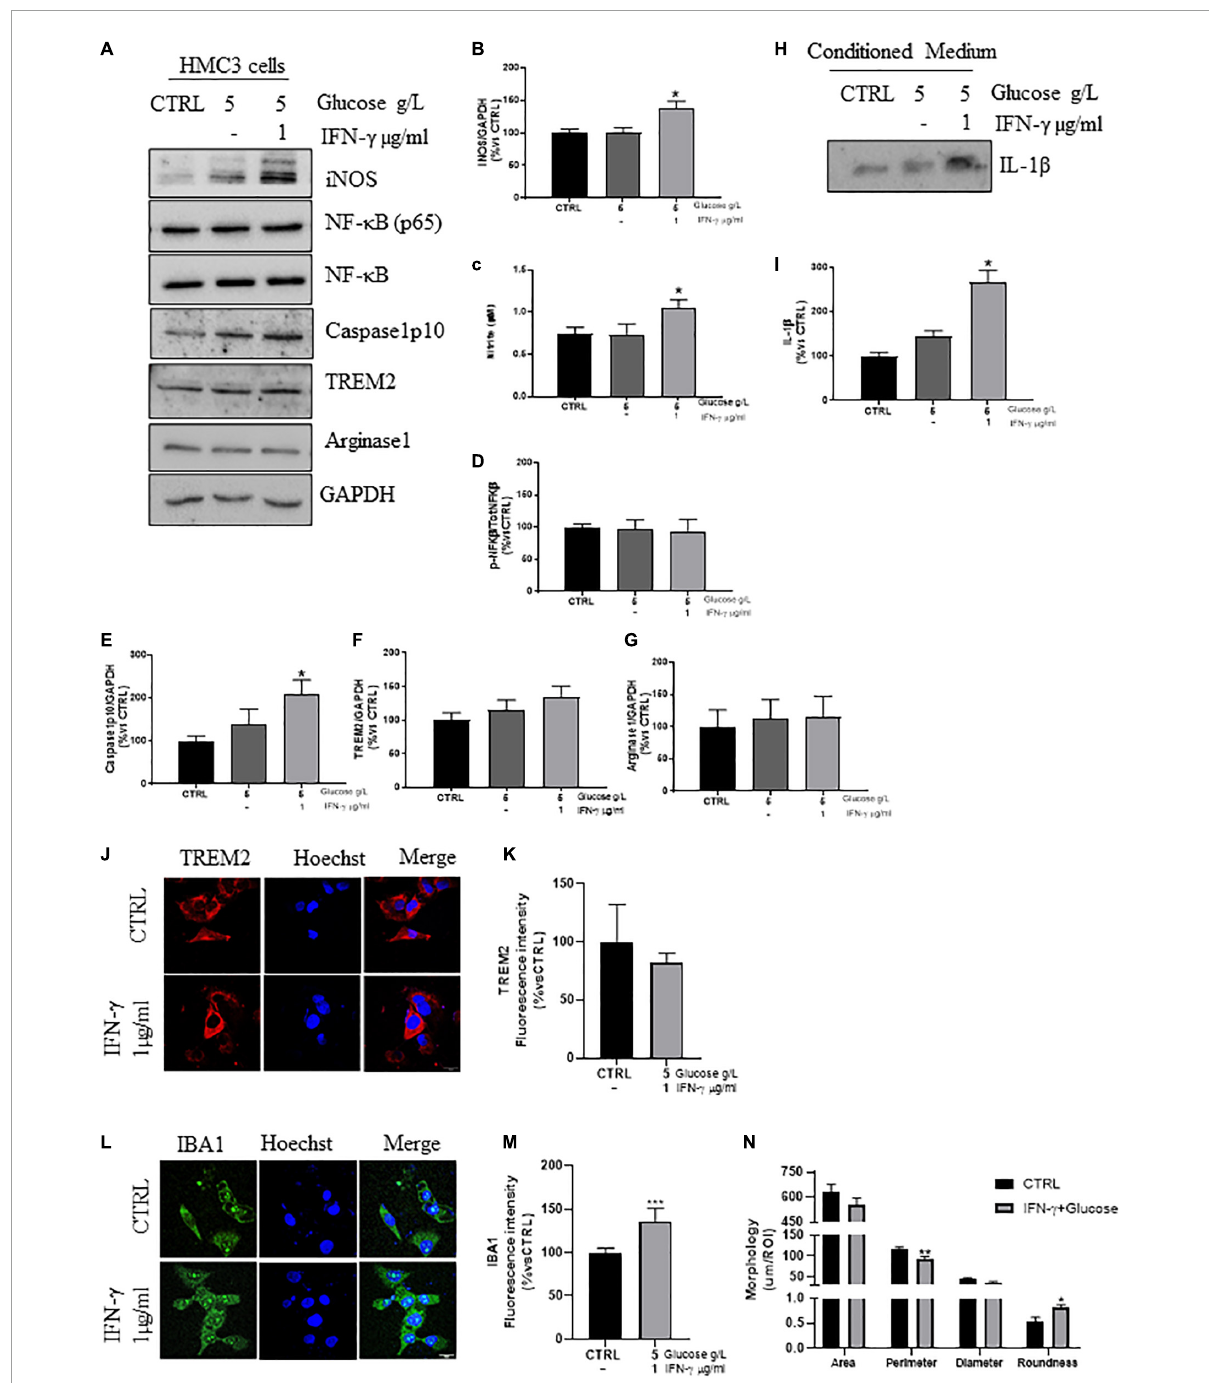
FIGURE1 Phenotypic markers expression in human microglial clone 3 cell line (HMC3) treated with IFN- γ + glucose. Western blot analysis and relative densitometry of iNOS (A,B) , Caspase1 (A,E) , NF- κ B(p65)/NF- κ B (A,D) , TREM2 (A,F) , Arginase1 (A,G) , in lysed HMC3 cells treated with glucose (final concentration 5 g/l) or IFN- γ 1 µ g/ml + glucose (final concentration 5 g/l) for 24 h in serum free medium vs. the reference protein GAPDH. IL-1 β expression (H,I) and nitrite quantification (C) in conditioned medium of HMC3 cell treated with glucose (final concentration 5 g/l) or IFN- γ 1 µ g/ml + glucose (final concentration 5 g/l) for 24 h. Results are the mean ± s.e. of independent experiments. N = 3 for Caspase1, NF- κ B(p65)/NF- κ B, IBA1, and IL-1 β . N = 5 for iNOS, TREM2, and Arginase1. Representative immunofluorescence and relative quantification of fluorescence intensity of TREM2 (J,K) , and IBA1 (L,M) and morphology analysis of IBA1 + cells (L,N) in HMC3 cells treated with IFN- γ 1 µ g/ml + glucose (final concentration 5 g/l) for 24 h. N = 3. Scale bar = 20 µ M. One-way ANOVA, followed by Dunnett’s test * p < 0.05, ** p < 0.01, and *** p < 0.001 vs. CTRL (glucose 4,5